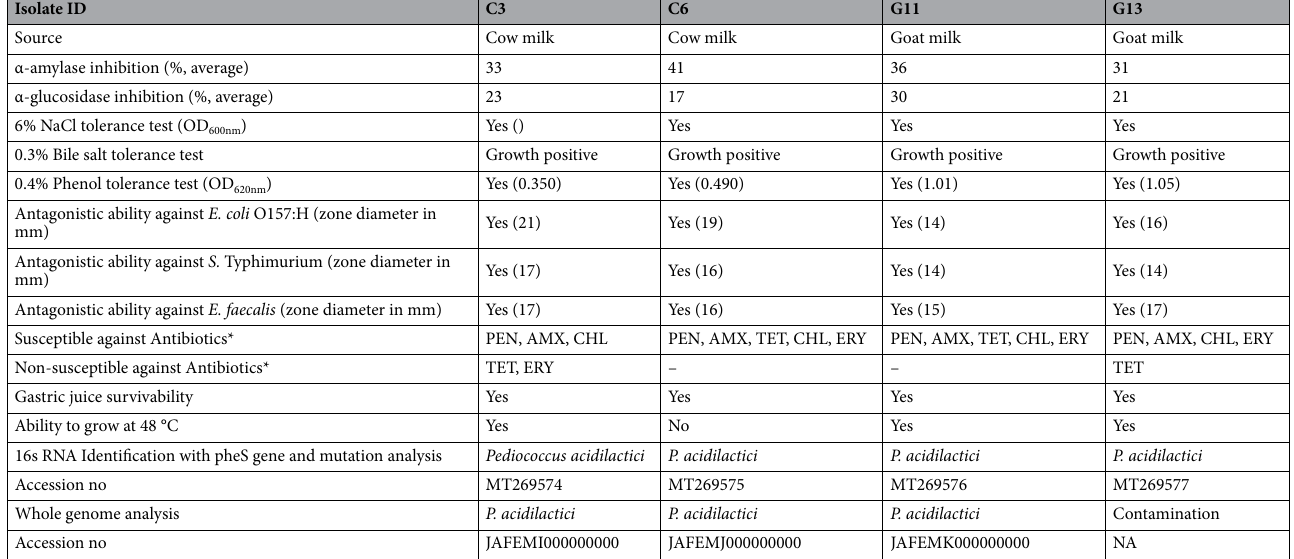
Table 1. Properties of the probiotic isolates. PEN Penicillin, AMX Amoxicillin, TET Tetracycline, CHL Chloramphenicol, ERY Erythromycin. *Cefoxitin, Ceftriaxone, Imipenum and Meropenum susceptibilities were not